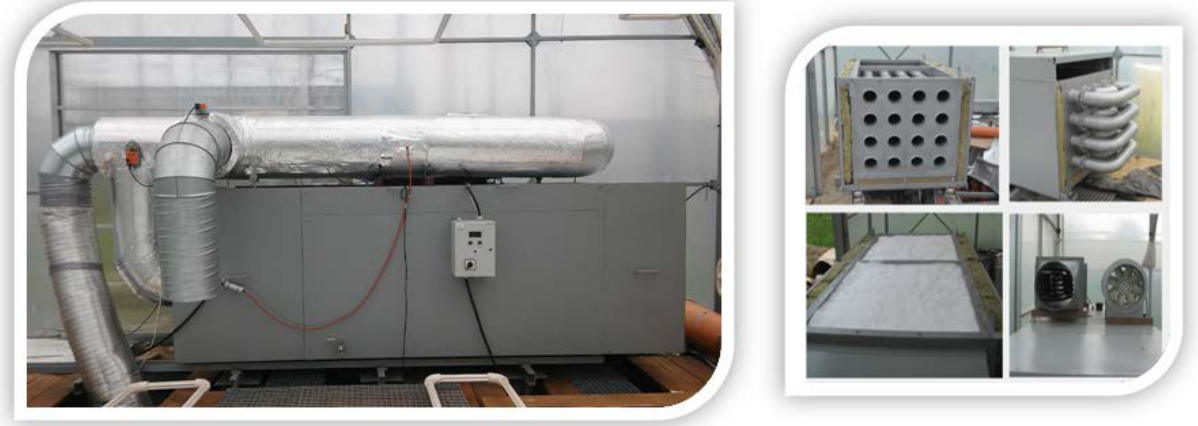
Figure 3. View of the PCM battery.